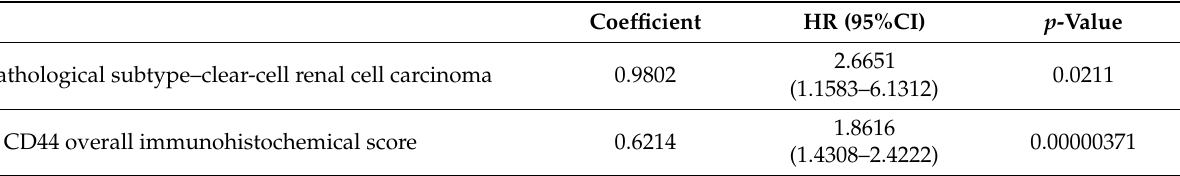
Table 5. Multivariate analysis of the relationship between CD44, MMP-2, and MMP-9 expression levels, histopathological subtype of renal cell carcinoma, and overall